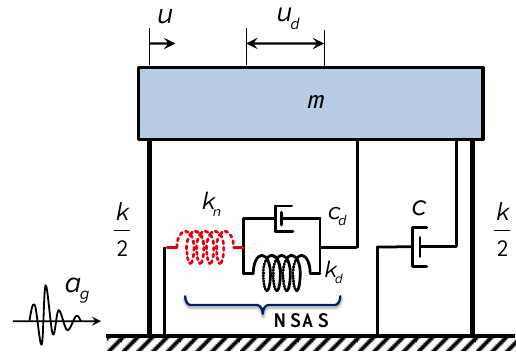
Figure 2. Model of a single-degree-of-freedom (SDOF) structure with proposed NSAS .